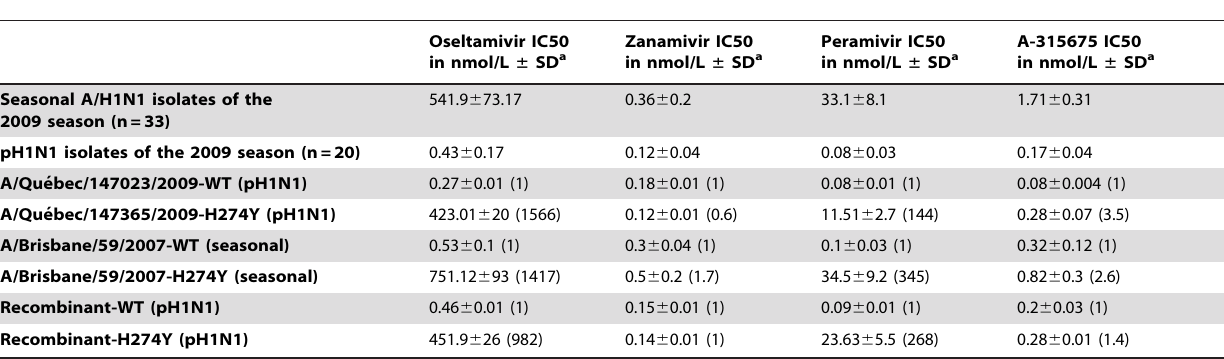
Table 1. Susceptibility profiles of pH1N1 isolates, A/Brisbane/59/2007-like A/H1N1 isolates of the 2009 season, and recombinant pH1N1 viruses as tested by NA inhibition